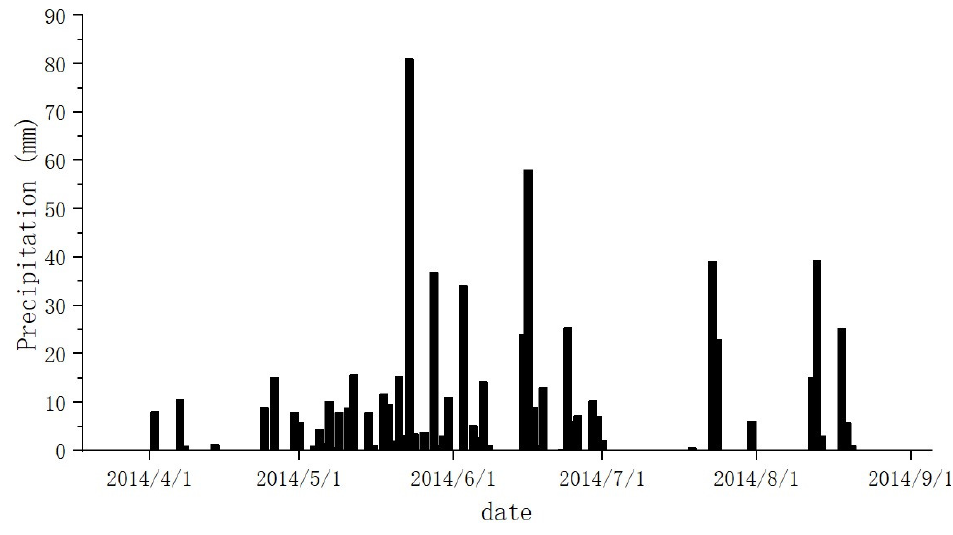
Figure 2. The precipitation events during the sampling period.